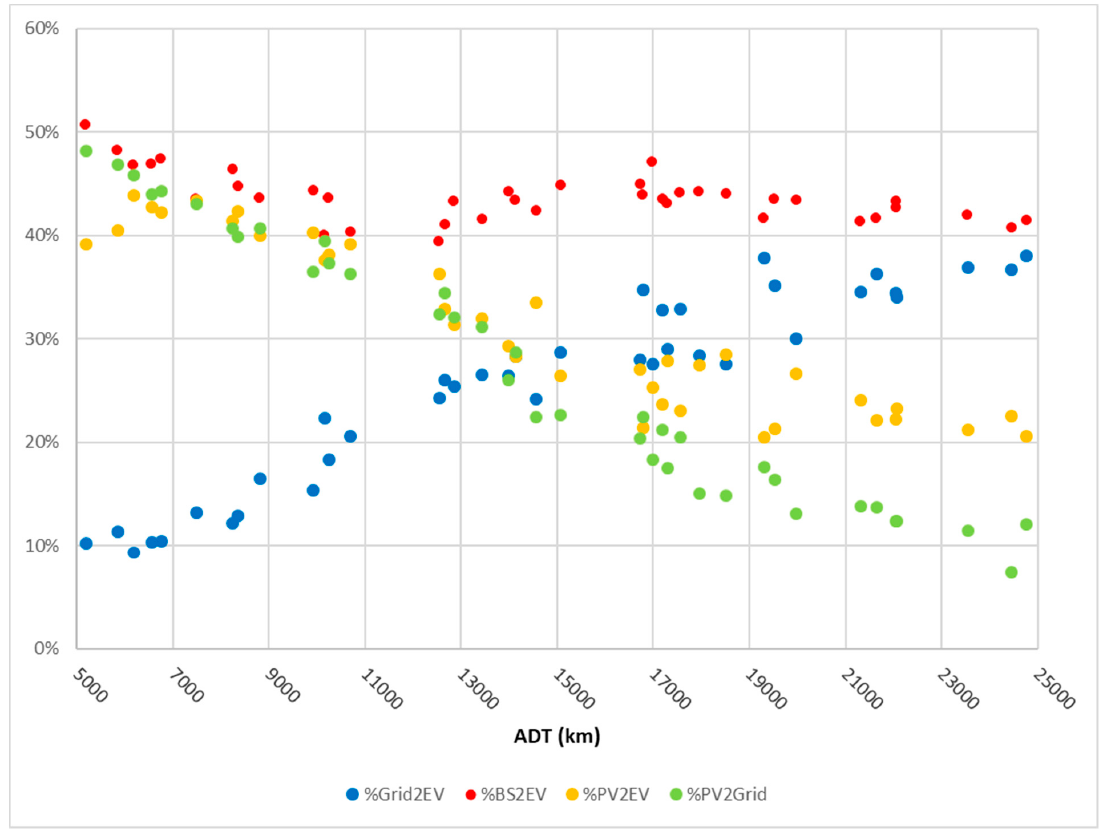
Figure 3. Energy source used to charge the EV and electricity discharged into the electrical grid with varying ADT in the base-case scenario with the solar-forecast-based strategy.